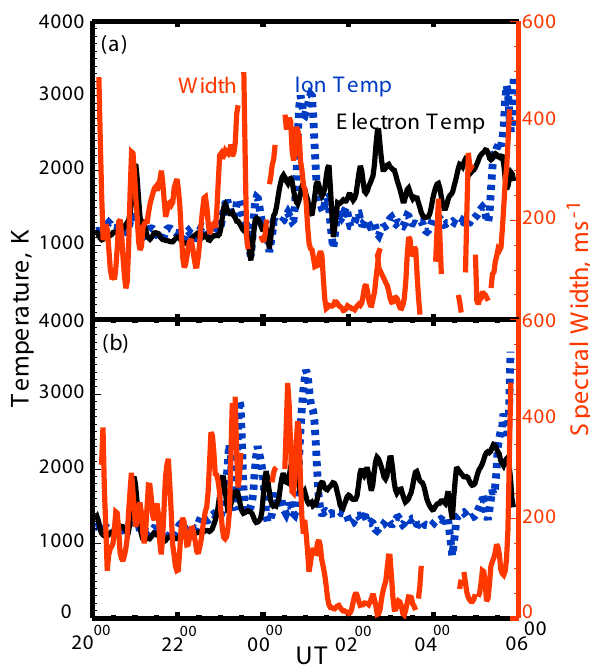
Fig. 7. Line plots from overlapping radar cells between (a) EIS- CAT beam 1, and (b) EISCAT beam 2, and appropriate CUTLASS Finland range cells, within the 71 ◦ N to 72 ◦ N latitude range. Elec- tron temperature is in black, ion temperature in blue (dotted) and spectral width is in